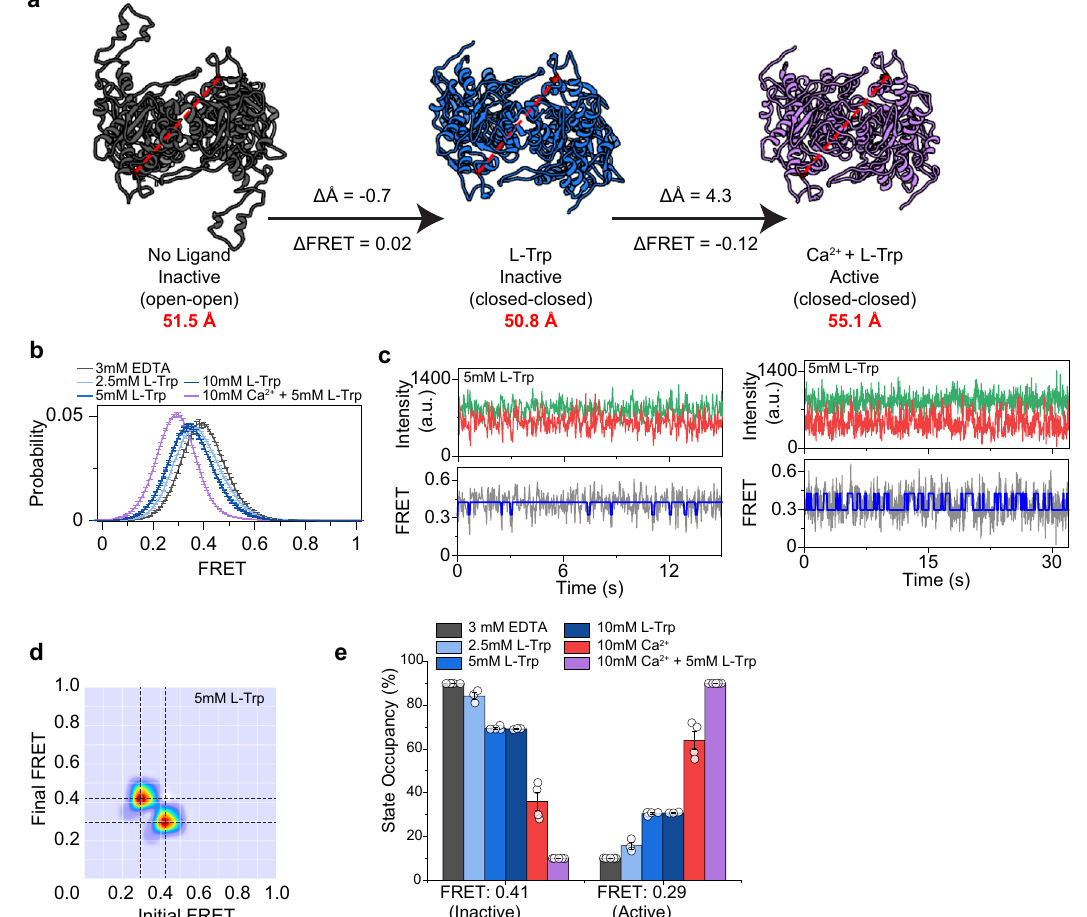
Fig. 3 L -Trp increases occupancy of the active state but is insuf fi cient for activation. a Top-down view of CaSR structures showing the distance between the C α of D451 (red) for the Ioo, Icc, and Acc conformations (PDB IDs: 5K5T, 7DTU, and 7DTV, respectively). Arrows show change in distance of the D451 C α and the corresponding predicted change in FRET. b smFRET population histogram in the presence of 3 mM EDTA, 2.5 mM L -Trp, 5 mM L -Trp, 10 mM L - Trp, or 10 mM Ca 2 + and 5 mM L -Trp. Histograms for 5 mM L -Trp and 10 mM L -Trp overlap. Data represent mean ± s.e.m. of n = 3 individual independent biological replicates. c Sample single molecule traces of D451UAA in 5 mM L -Trp showing donor (green) and acceptor (red) intensities, corresponding FRET (gray), and idealized FRET trajectory from HMM fi t (blue). Sample traces show particles exhibiting different behaviors in the same condition with infrequent and very brief transitions (1 – 2 datapoints), or frequent and brief transitions (5 – 10 data points). d Transition density plot of D451UAA. Dashed lines represent the most frequently observed transitions and were used for multiple-peak fi tting of FRET histograms. e Occupancy of the two FRET states of the VFT in the presence of increasing ligand concentrations. Values represent mean ± s.e.m. area under individual FRET peaks from n = 3, 4, or 5 independent biological